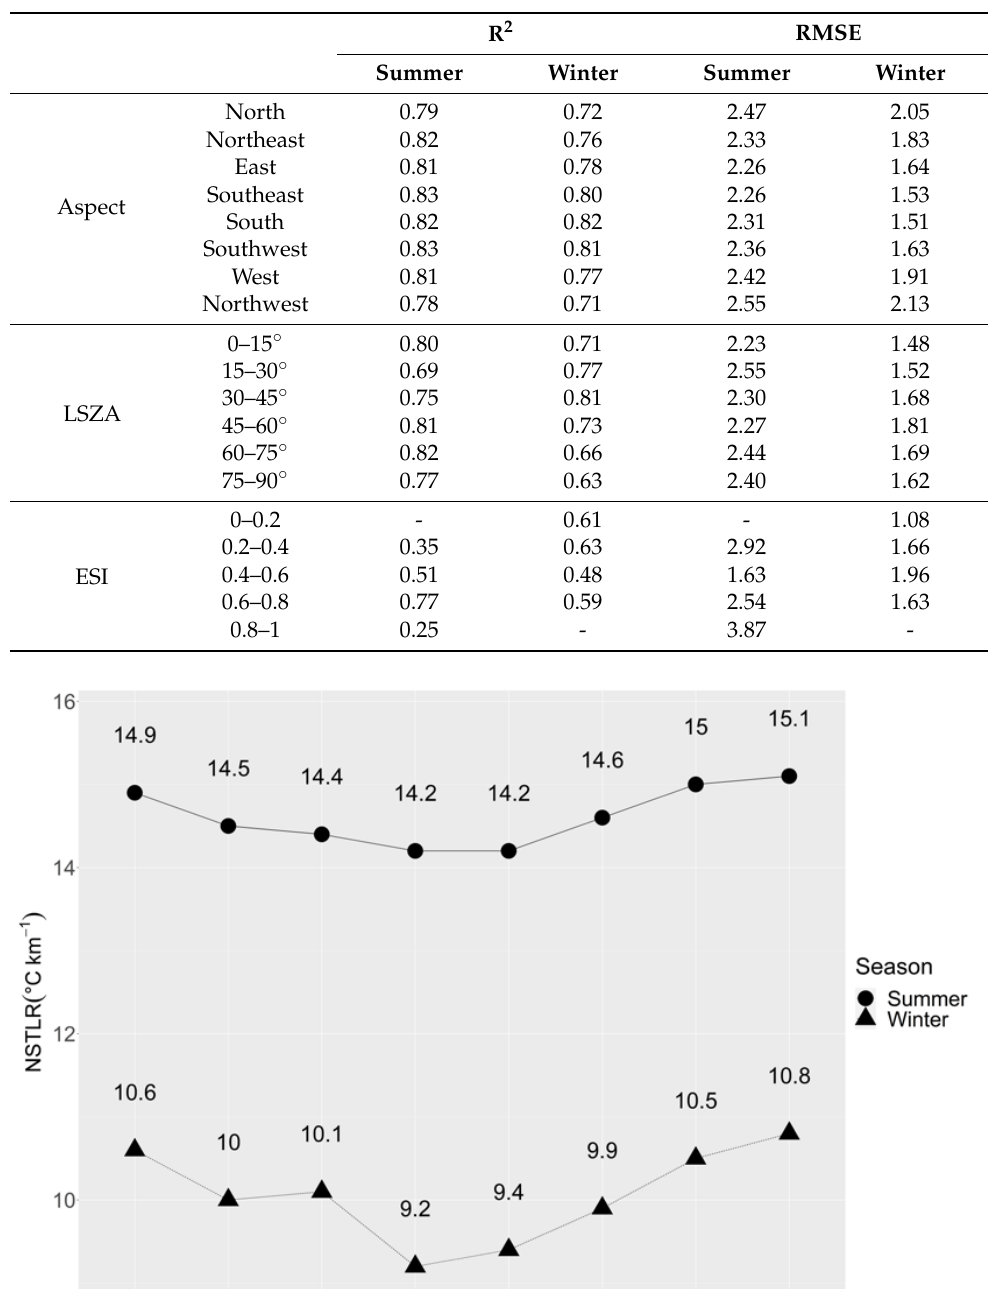
Table 3. Metrics of simple regression models. R 2 : coefficient of determination; RMSE: root mean square error; LSZA: Local solar zenith angle; ESI: Evaporative Stress Index. The gaps in the ESI data (-) are shown where there are not data of these ranges in this season of year.